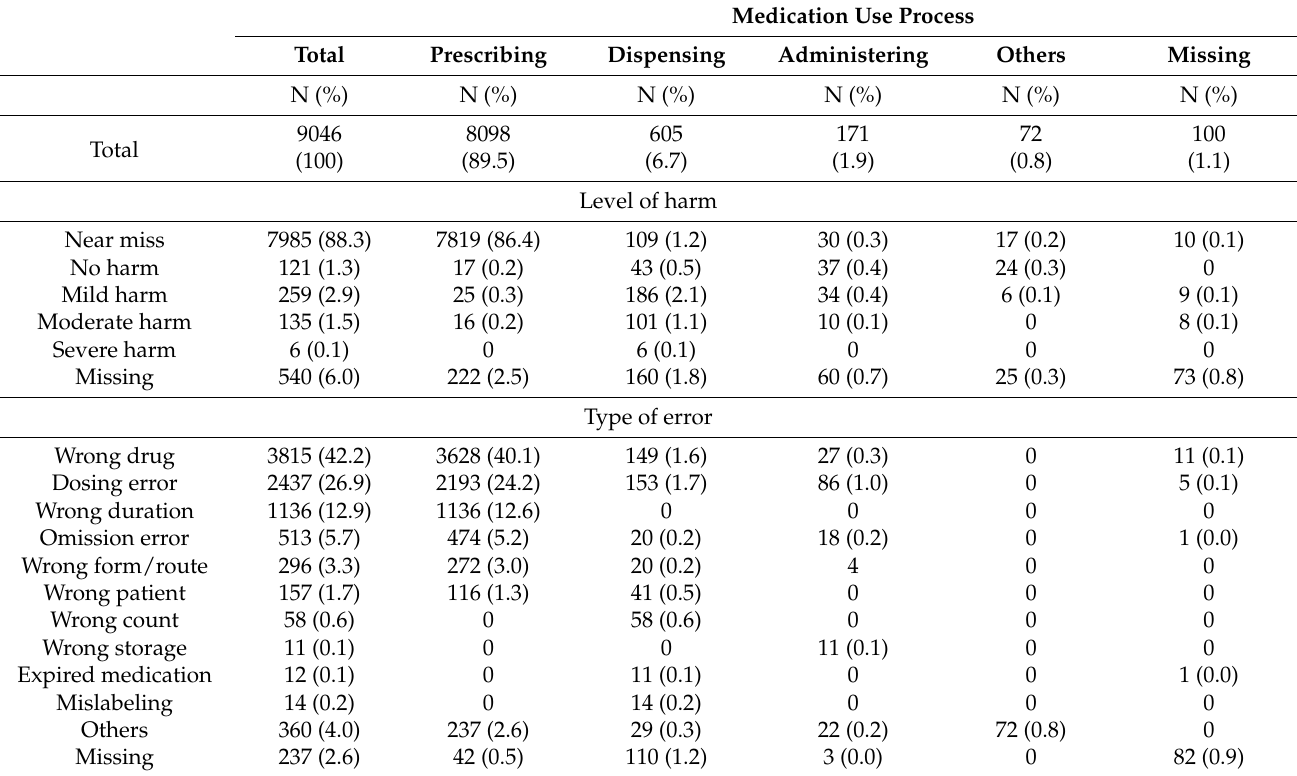
Table 1. Level of harm and type of medication errors by medication use process.